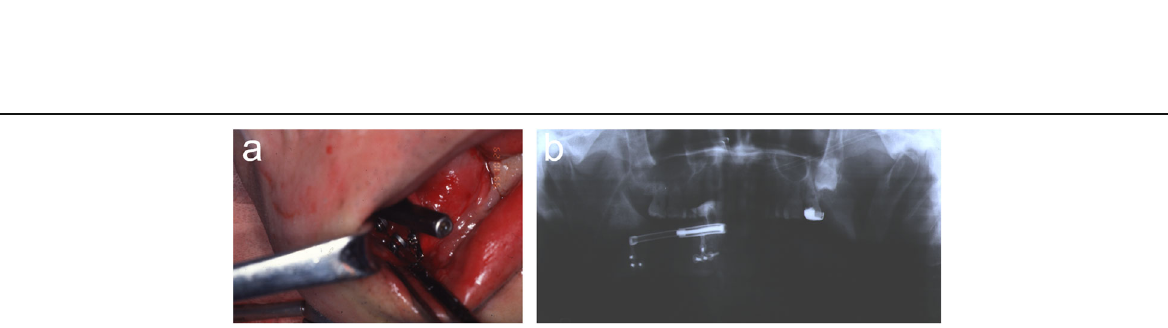
Fig. 1 a Orthopantomogram before treatment. b Orthopantomogram and c 3-D computed tomography scan after segmental mandibular resection